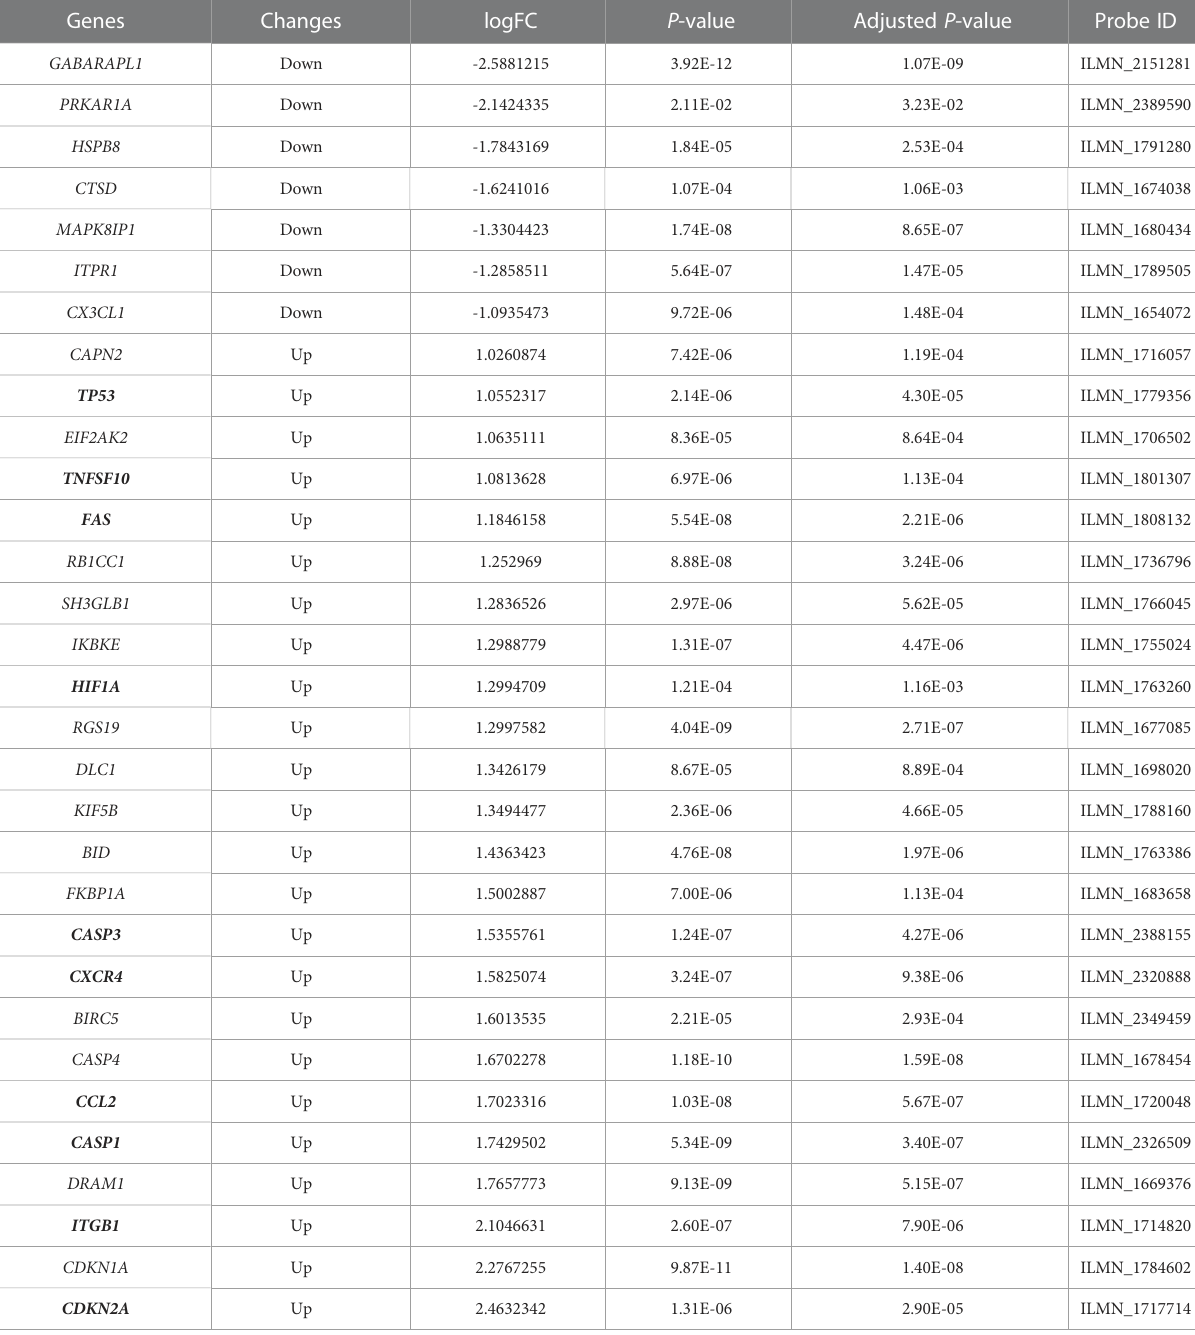
The top ten hub genes are shown in